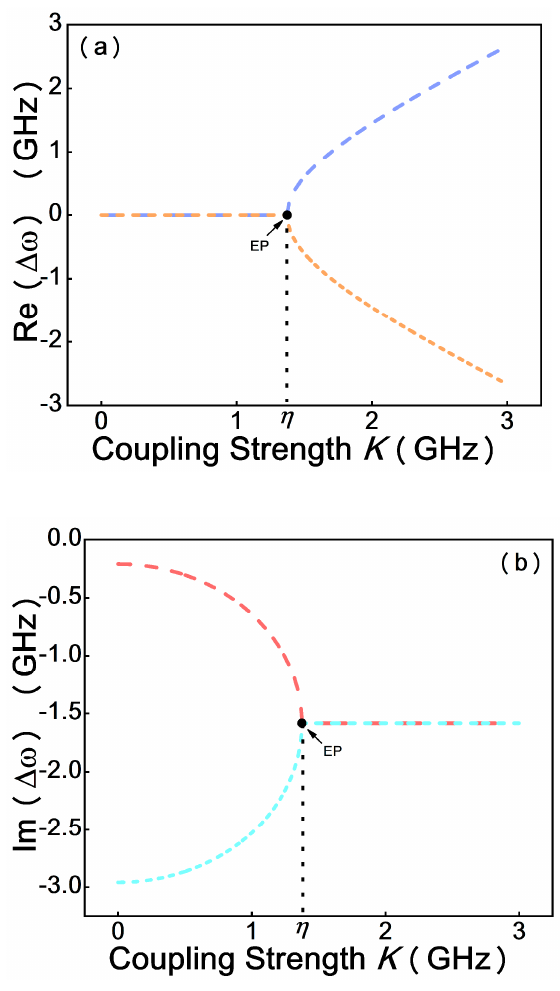
ωΔ ωΔ , ( a )) and imaginary ( Im ( ) ( b )) parts of the eigen-